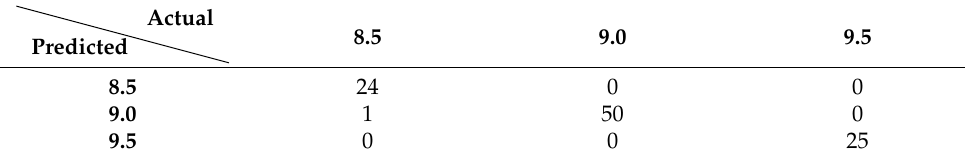
Table 5. Confusion matrix of quadratic discriminant analysis (QDA).